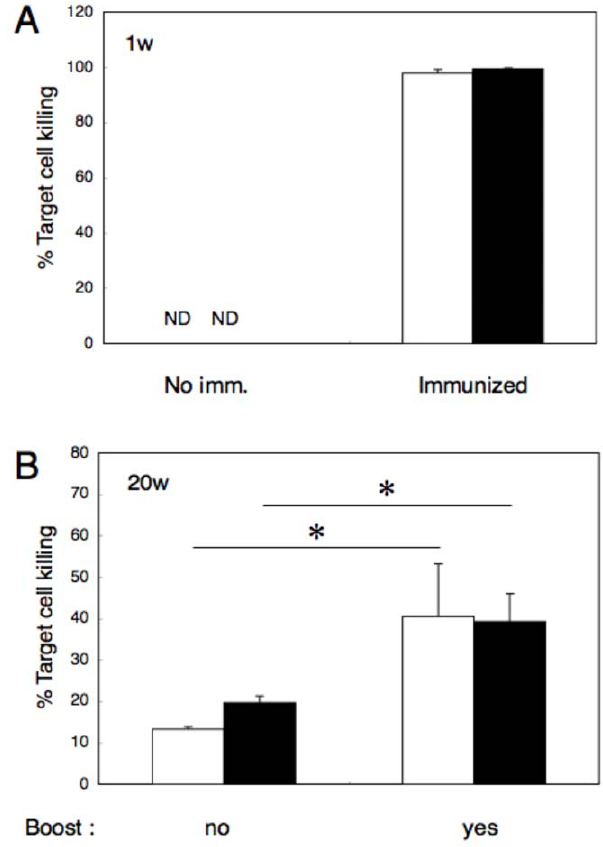
Figure 5. Effect of in vivo elimination of CD4 + T cells on the induction of primary and secondary CTL responses by OVA 257-264 -liposomes. Mice with (closed box) or without (open box) CD4 + T-cell elimination were immunized with 50 m l of OVA 257-264 - liposome solution in the presence of 5 m g CpG, and CTL induction was monitored. A , CTL response 1 week after immunization. B , CTL response 20 weeks after immunization with or without booster injection. In vivo CTL assay was performed 3 days after the booster injection. Data represent mean percent killing and SE of three mice per group. ND, not detected. *, significant difference (p .